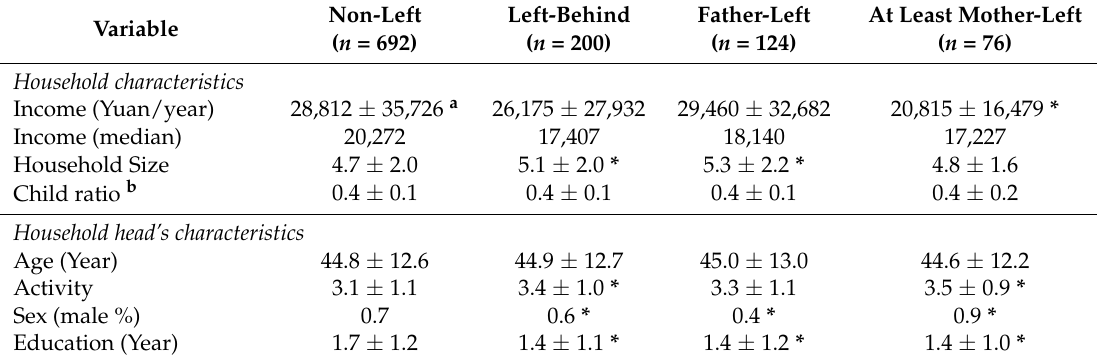
Table 1. Comparison of characteristics between different